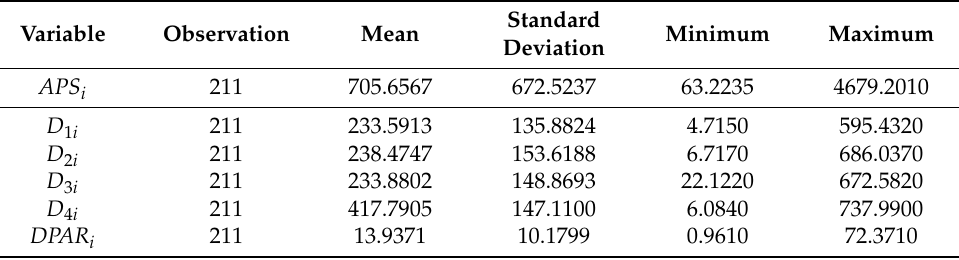
Table 1. Summary statistics of passenger flow of stations and their influencing factors.